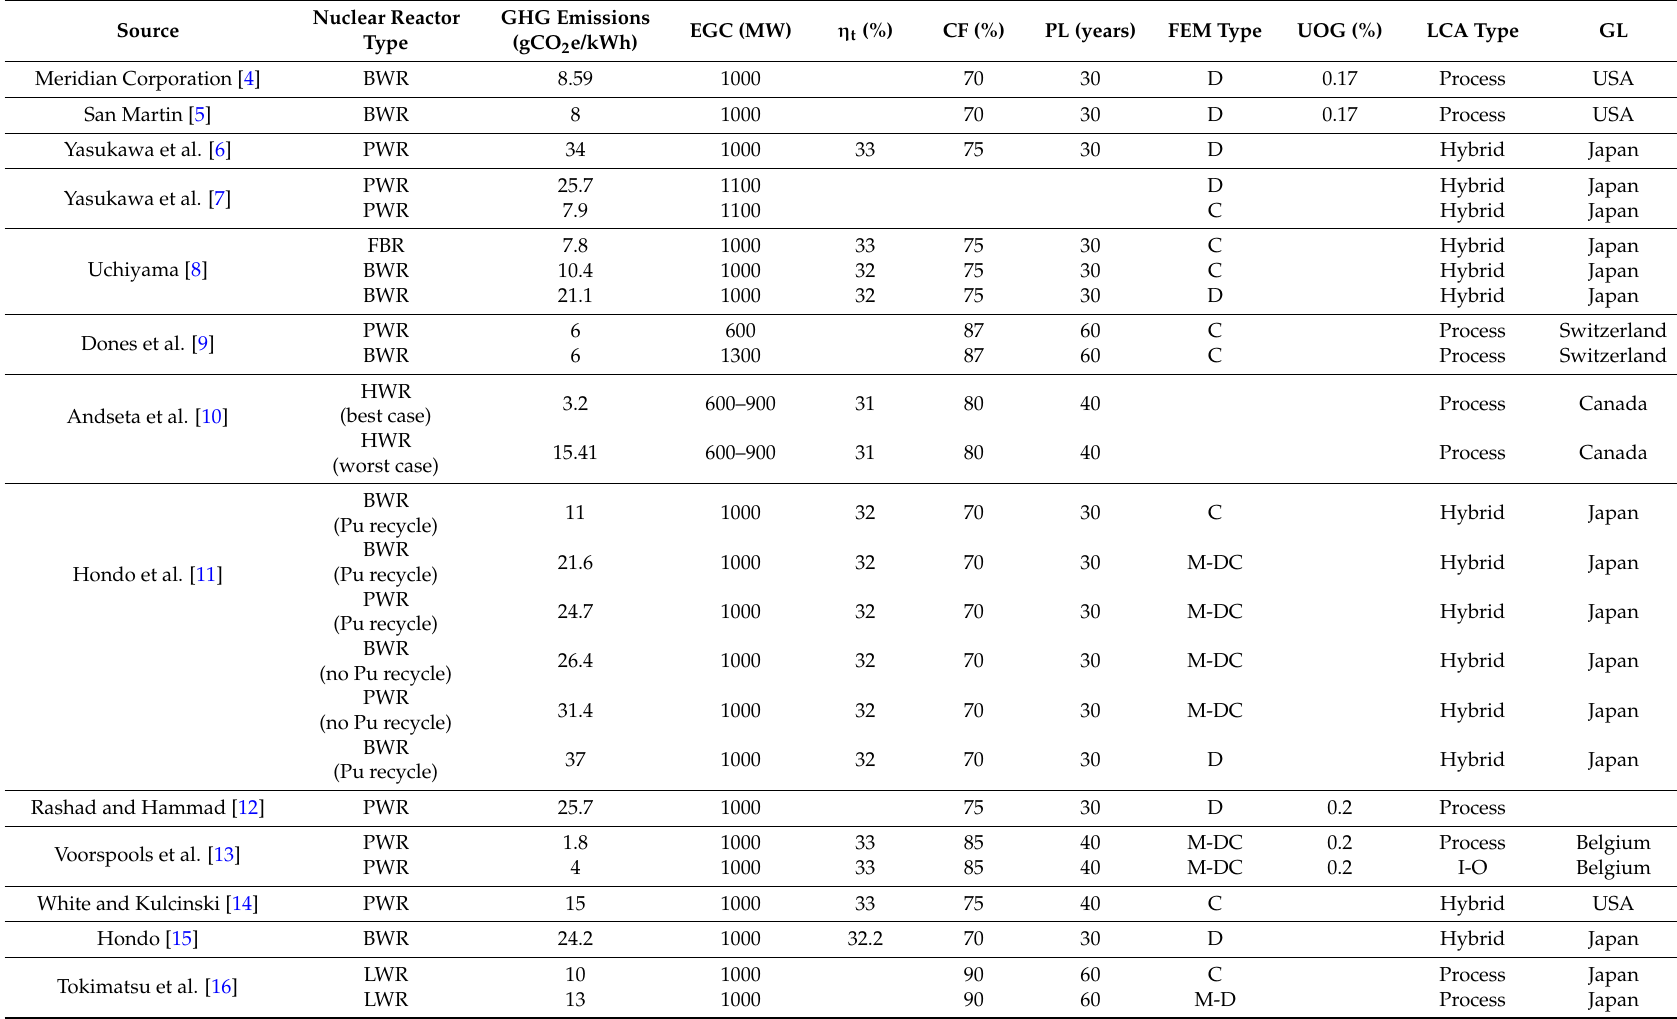
Table 1. GHG emissions for reactor-based nuclear power generation